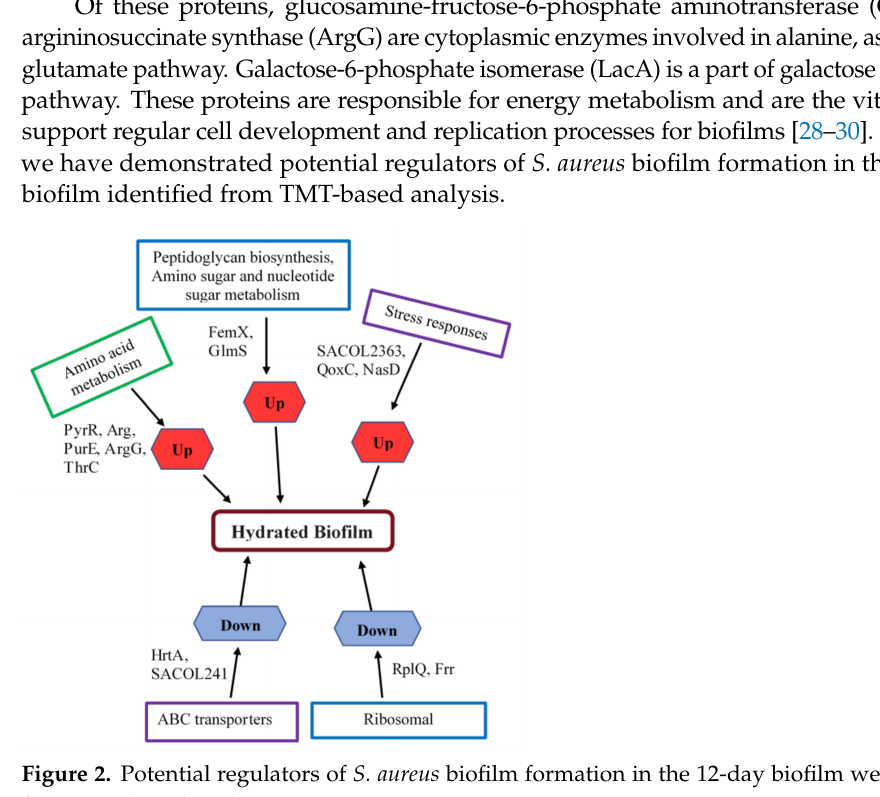
Figure 2. Potential regulators of S. aureus biofilm formation in the 12-day biofilm were identified from TMT-based